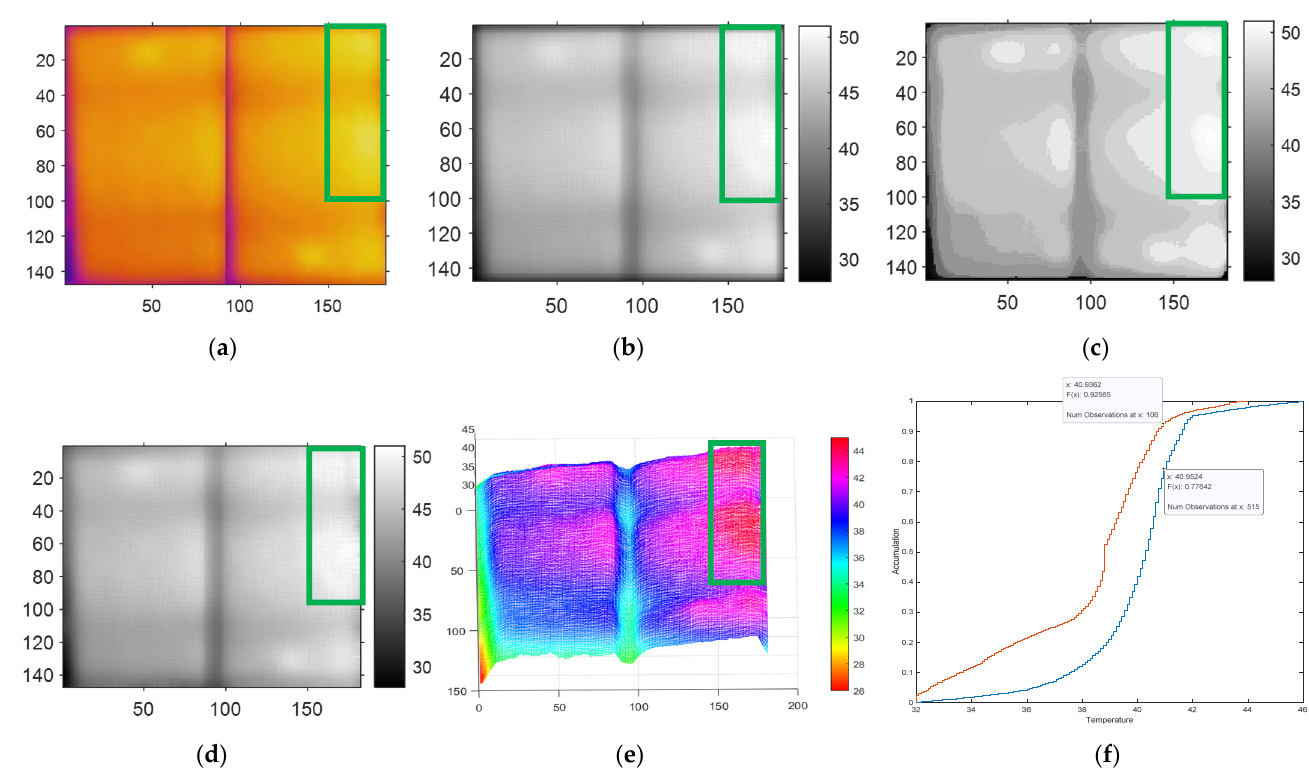
Figure 8. Comparison of different filtering methods with irradiance at 500 W/m 2 : ( a ) Original IR image. ( b ) Mean filter after grayscale treatment. ( c ) Median filter after grayscale treatment. ( d ) Im- proved box filter after grayscale treatment. ( e ) Improved box filter after 3D image. ( f ) Cumulative chart comparison of normal operation and abnormal conditions of solar